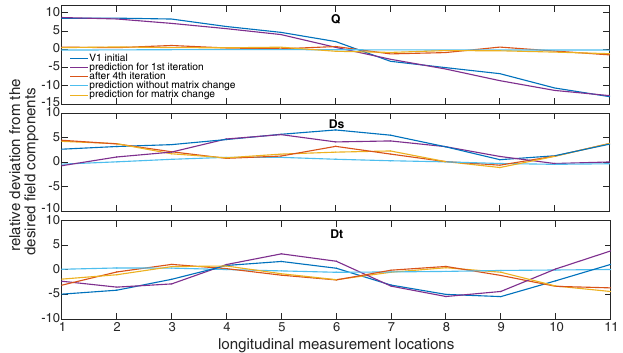
V1 initial prediction for 1st iteration after 4th iteration prediction without matrix change prediction for matrix change